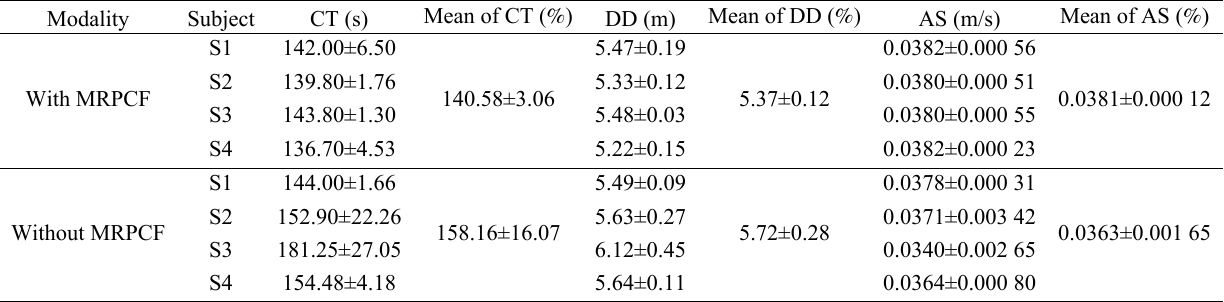
Fig. 10 Subjective questionnaire results. Table 5 Performance of manual-control multi-robot navigation tasks with and without MRPCF. Note that CT is task completion time, DD is driving distance, and AS is average